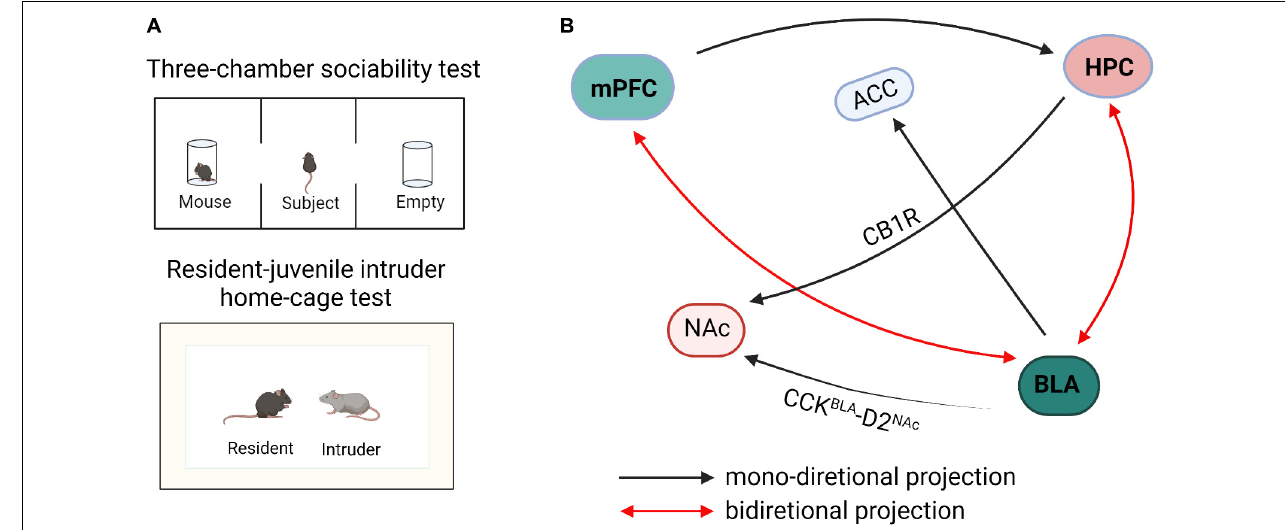
FIGURE 1 | Schematic diagram of neural circuits within the social exploration. (A) The paradigm diagrams of social exposure behaviors. (B) The neural networks of social exploration. mPFC, medial prefrontal cortex; HPC, hippocampus; BLA, basolateral amygdala; NAc, nucleus accumbens; ACC, anterior cingulate cortex; CB1R, cannabinoid type 1 receptor; CCK,